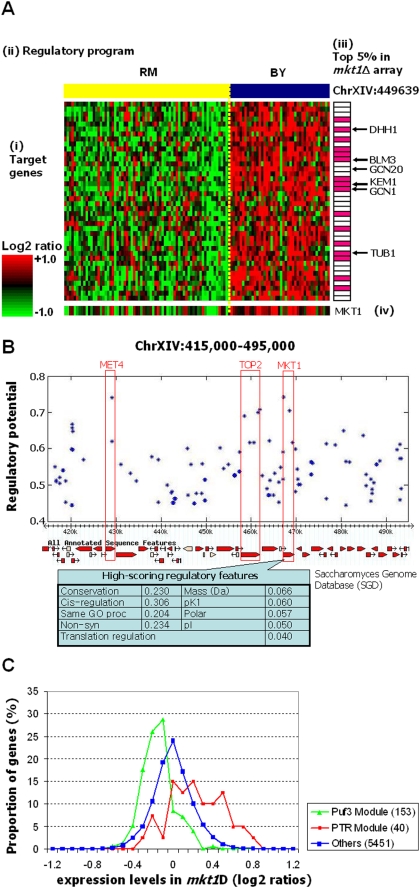
The post-transcriptional regulation (PTR) module.(A) A module of 40 target genes and its regulatory program, consisting of a genotype marker on Chromosome XIV. The module is strongly enriched for genes involved in post-transcriptional regulation processes (Figure S6), and contains many of the regulators of the Puf3 module, including P-body components Dhh1 and Kem1, and both components of the Gcn1/Gcn20 complex that regulates translation under conditions of nutrient starvation. The module's only predicted regulator is at 449,639 on Chromosome XIV. (i) The mRNA expression profiles (log2 ratios) of the 40 module target genes, where the rows are genes and the columns are arrays (segregants), sorted by the genotype of the segregants in the linked region on Chr XIV (shown in (ii)). (iii) Annotation of the 16 module members that are in the top 5% of genes up-regulated in the mkt1Δ array in an RM background (hypergeometric p<10−10). (iv) Expression profile of MKT1 in the original arrays; MKT1 was not included in our original analysis, as it did not meet our stringent cutoff for variation in expression values. (B) Of the 30 genes in the chromosome XIV region selected as the module's regulator, the highest regulatory potential is obtained by MKT1 (Table S9). Also shown are the regulatory features that contributed the most to the selection of a SNP in Mkt1 as the causal polymorphism: conservation, linkage to the adjacent chromosomal marker (cis-regulation), common GO process annotation with target genes, the presence of non-synonymous coding mutations and their effect on properties of the resulting protein, and to a lesser extent being annotated as regulating translation. (C) RNA expression levels of an mkt1Δ in an RM background. Expression-value distribution for the Puf3 Module target genes (green), the PTR Module target genes (red), and the remaining genes (dark blue). The results show a modest (average fold change 0.9) but consistent down-regulation of the Puf3 Module (KS p-value<10−23) and up-regulation of the PTR Module (KS p-value<10−6).